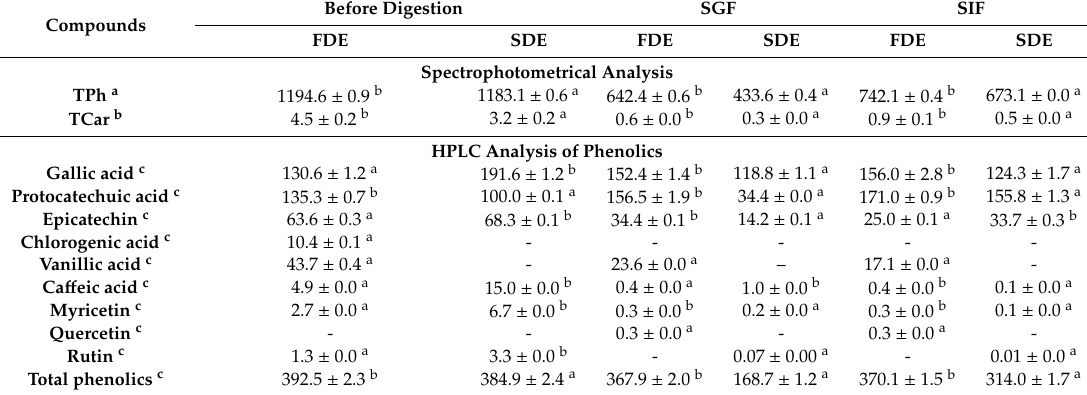
Table 1. Spectrophotometrical and HPLC analysis of bioactive compounds content before and after in vitro gastrointestinal